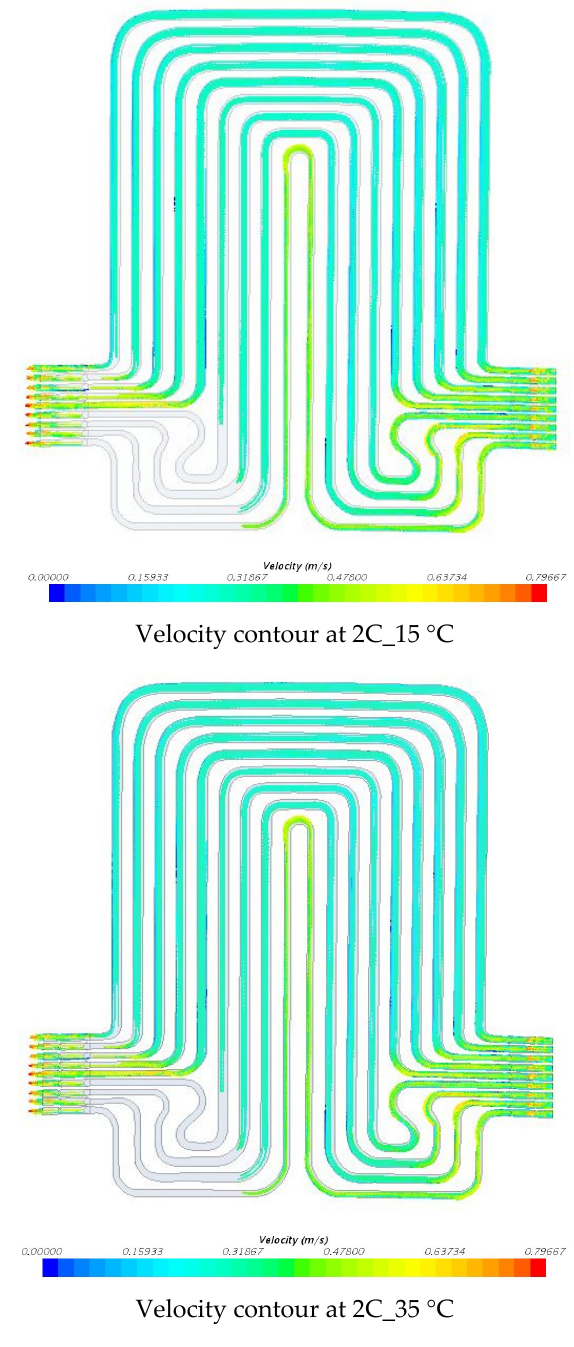
Figure 16. Velocity distribution at 40 A discharge current and 5 °C, 15 °C, 25 °C, and 35 °C coolant inlet temperature.